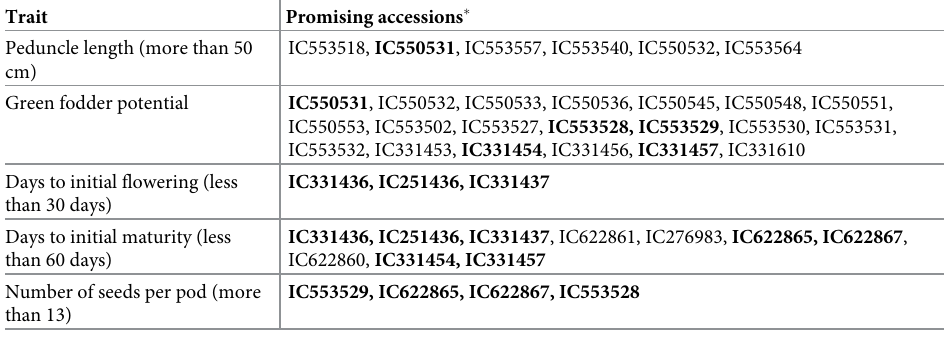
Table 4. Characterization of germplasm accessions on the basis of morphological observations on desirable traits.